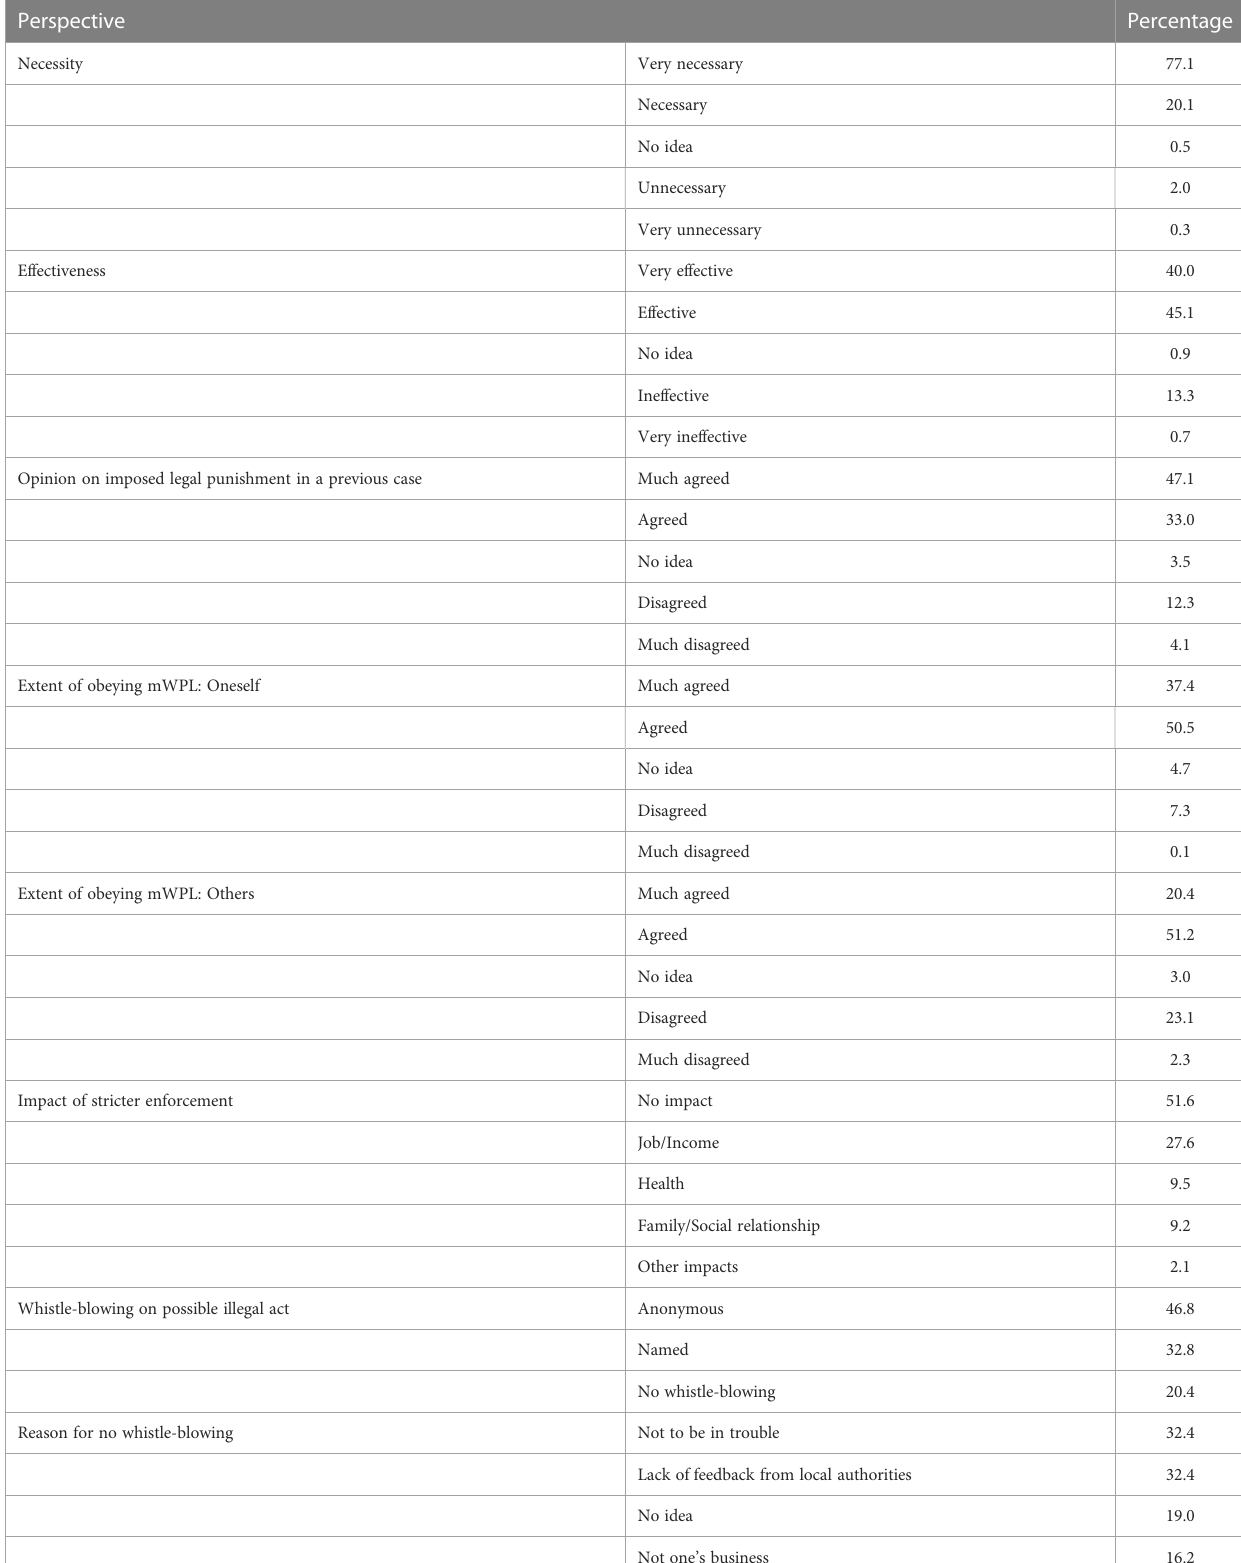
TABLE 3 Percentage distribution of responses regarding perspectives toward Wildlife Protection Law for marine species